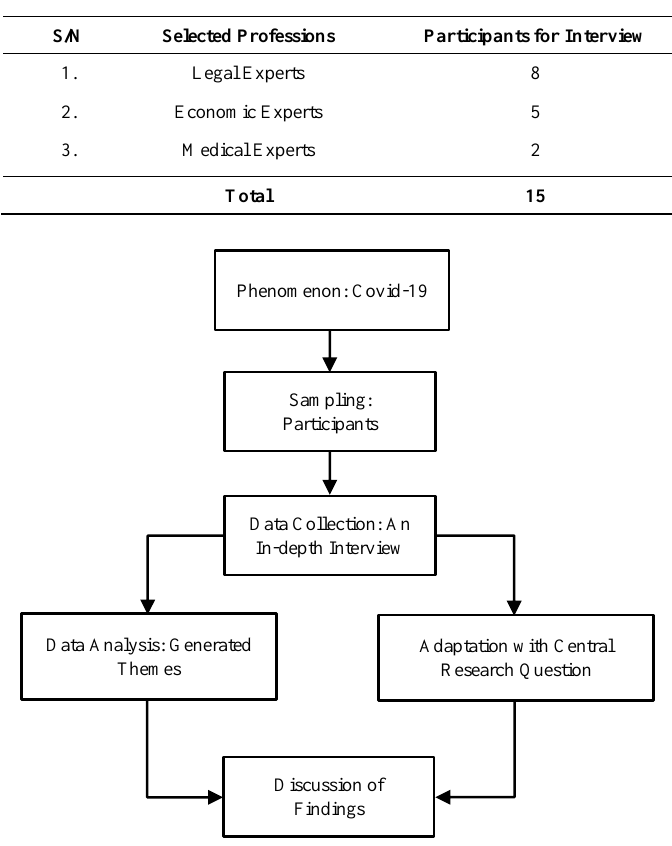
Figure 1. Flowchart of Qualitative Research Methodology employed in this